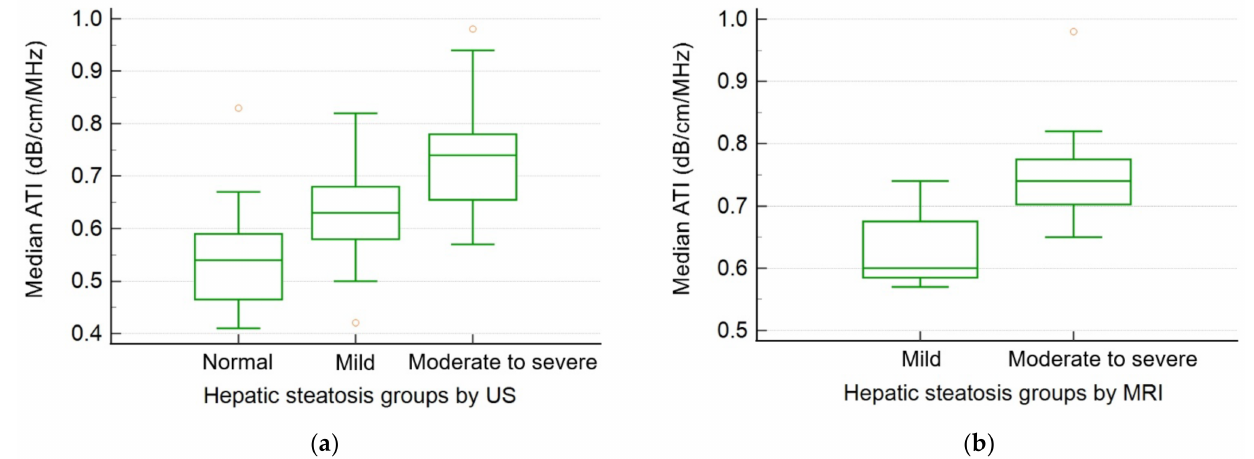
Figure 3. Box–whisker plots of median ATI values for each hepatic steatosis group ( a ) according to US echogenicity and ( b ) MRI-PDFF value. US: ultrasonography; ATI: attenuation imaging; MRI: magnetic resonance imaging; PDFF: proton density fat fraction.